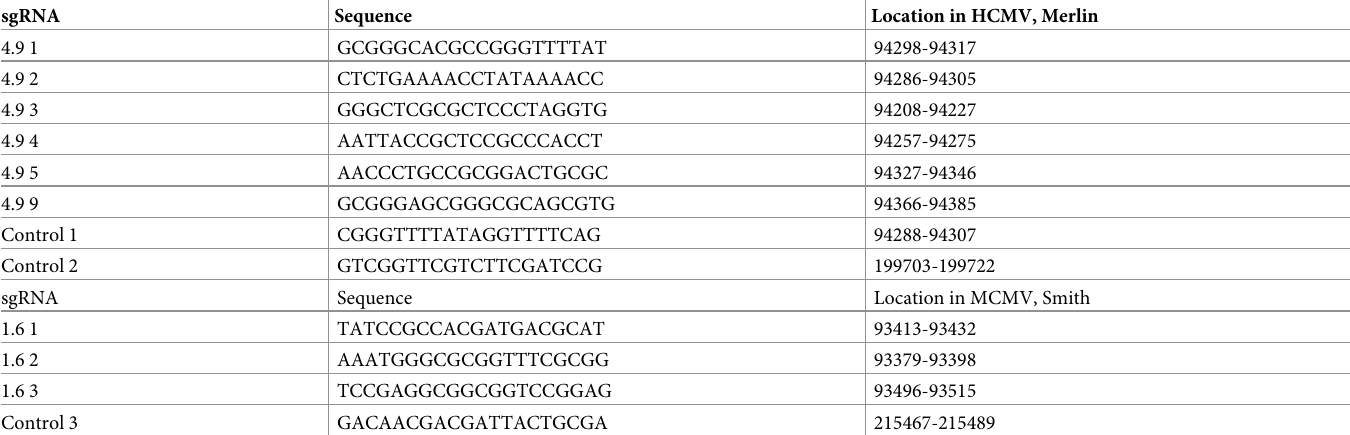
Table 1. Sequences and genomic locations of the single-guide RNAs